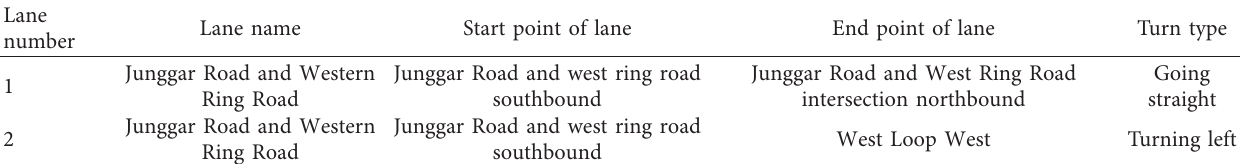
Table 3: Description information for automatically detected lane.